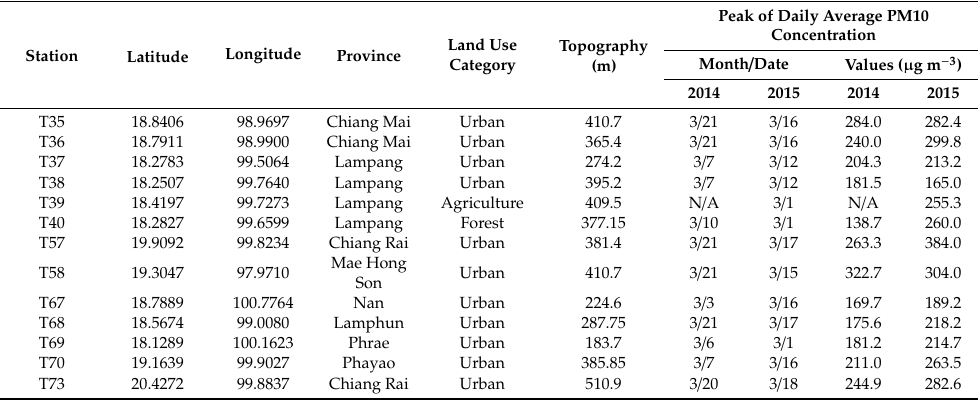
Table 1. Latitude, longitude, province, land use category, topography (m) above mean sea level, dates when the peak daily average PM10 concentrations occurred in 2014 and 2015, and the peak daily average PM10 concentrations for both years for the 13 ground stations. Station Latitude Longitude Province